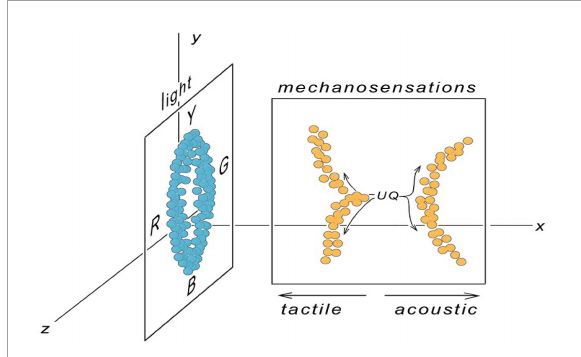
FIGURE2 The E-space from Figure 1 reconfigured for 3 dimensions, with mechanosensations and light qualia each occupying their own 2D surface oriented in one of many possible ways. Experiences are shown as point clouds, less compact than in the previous figure, as a reminder that each point in E-space represents the action of a selector circuit (SC) responding to a particular sensory stimulus. The overall density of points is a reflection of how many SCs are dedicated to each sensory modality, and would undoubtedly, for a fully evolved consciousness, be much greater than shown. Here, strictly as a thought experiment, acoustic and tactile sensations are supposed to originate from a common ur-quale (UQ), and share a common axis representing pitch (the y axis) in accord with the ideas of von Békésy. In addition, the experience of pain (the pinprick in Figure 1 ) has been expanded so as to encompass both sharp and dull pain along the same axis as acoustic pitch. Orienting the light plane along this same axis would imply that the yellow/blue axis is pitch-like in some way, while the red/green axis is not. But trajectories along the tactile/acoustic axis intersect the plane for light experience, implying a link between these. As discussed more fully in the text, such implied relationships are difficult to justify, yet are an inescapable feature of mapping more than one category of experience to a space with too few dimensions. Allowing E-space to have more dimensions, perhaps many more dimensions, avoids this